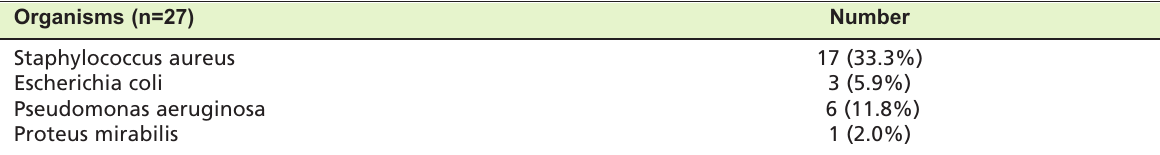
Organisms isolated from culture Table II: